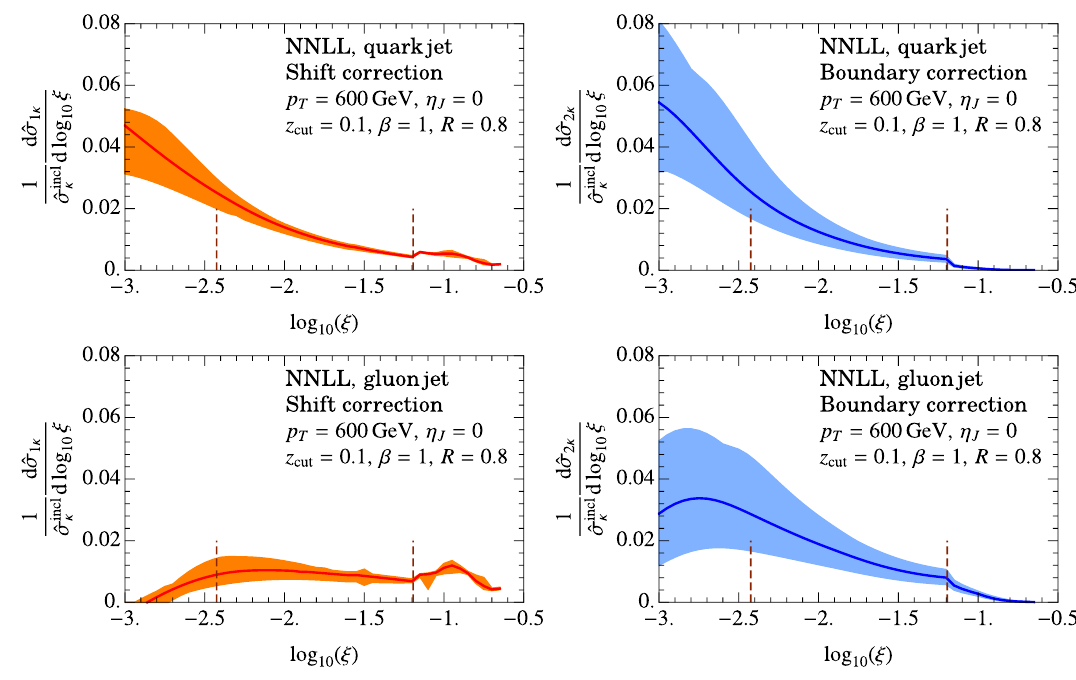
Figure 6 . Weighted cross sections for shift and boundary power corrections. Vertical lines denote the extent of the SDOE